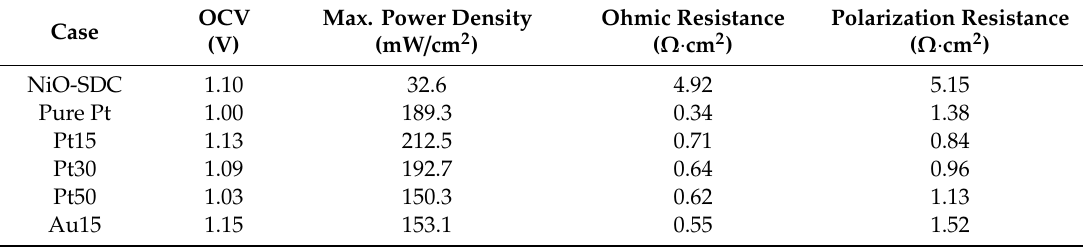
Table 2. Electrochemical performances of the TF-SOFCs with di ff erent nano-composite